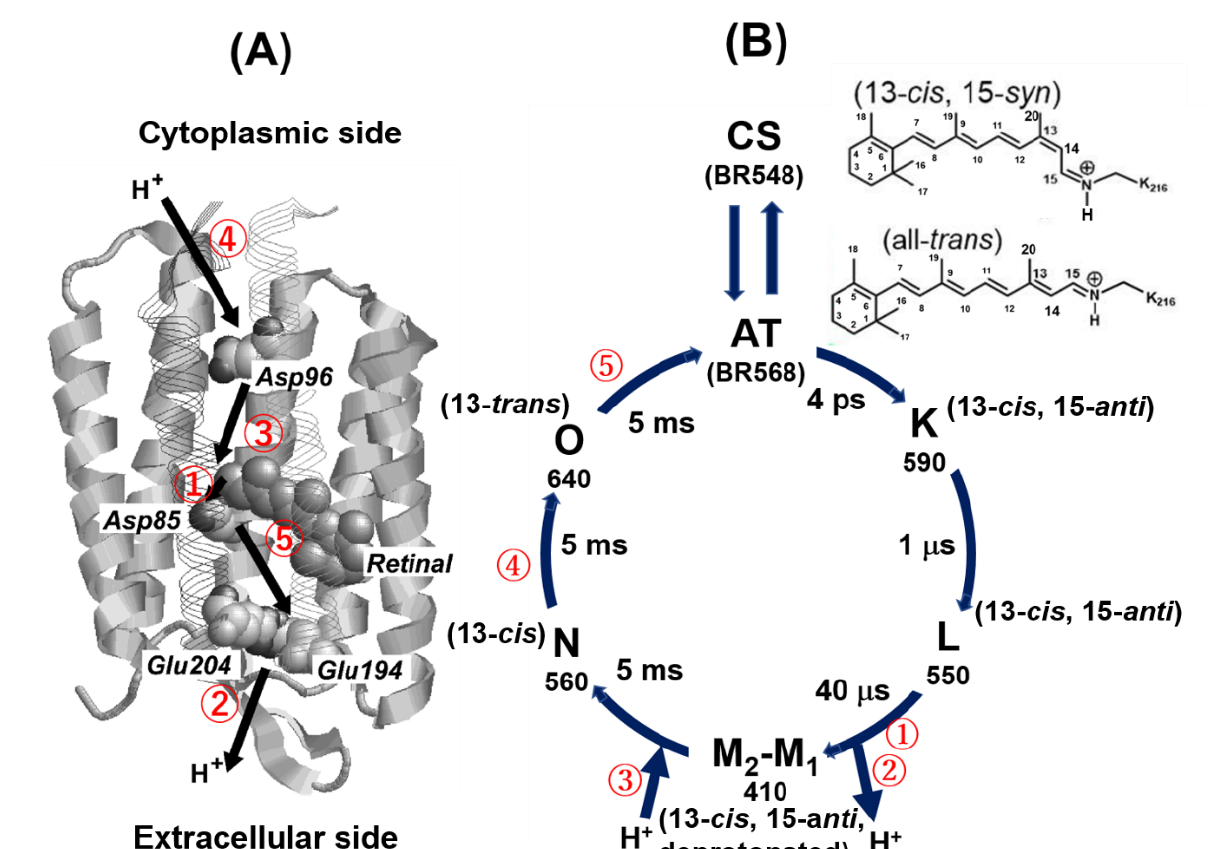
Figure 1. ( A ) Structure and proton transport pathways of bacteriorhodopsin (BR) (PDB: 1C3W). ( B ) Schematic of the BR photocycle. Approximate half-life for each transition and the absorption maximum of each intermediate are shown for the K, L, M 1 (early M), M 2 (late M), N, and O intermediates [7].